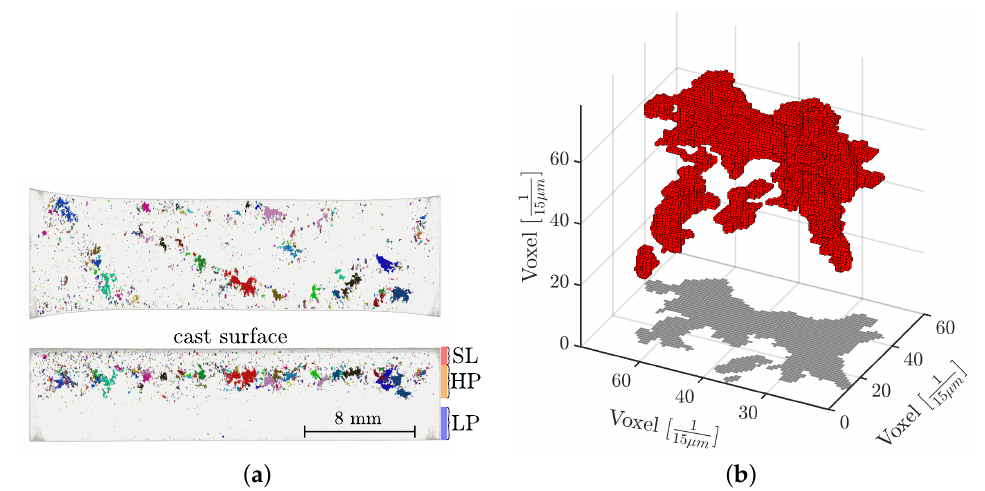
Figure 7. Representation of an exemplary CT scan. ( a ) CT scan of a thick-walled specimen. ( b ) Projec- tion of clustered